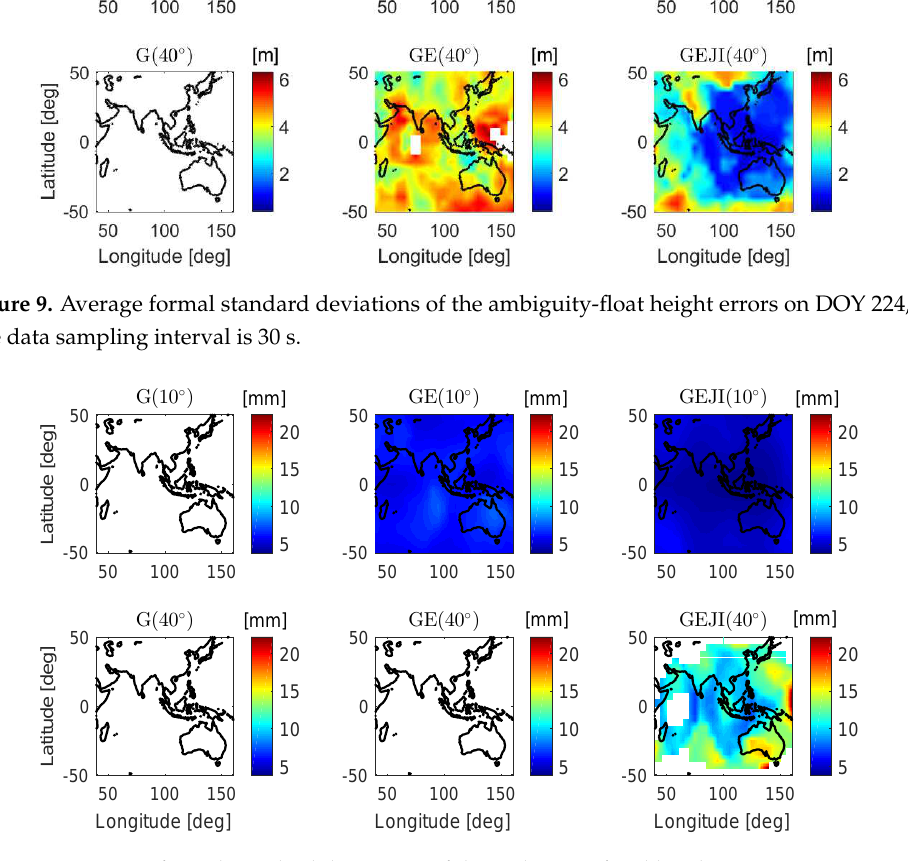
Figure 10. Average formal standard deviations of the ambiguity-fixed height errors on DOY 224, 2018. The data sampling interval is 30